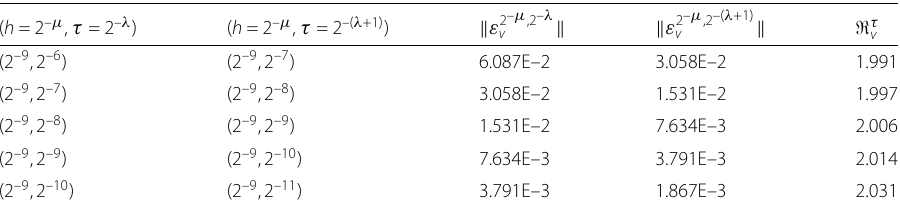
Table 2 Maximum errors and the order of convergence of approximate solution ˜ v with respect to τ for Example 1